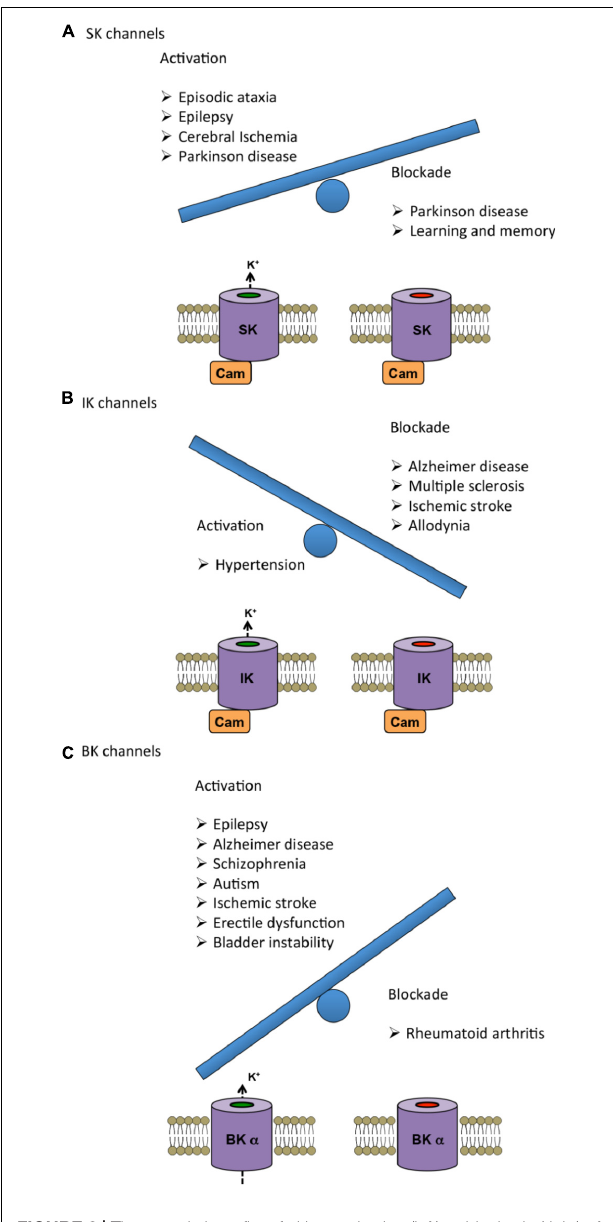
FIGURE 2 | Therapeutic benefits of either activation (left) or blockade (right) of K Ca channels represented as a weighing scale. The heavier balance indicates the modulation (activation or blockade) that has been reported advantageous in a larger number of diseases. (A,C) In the case of SK and BK channels, activation shows more beneficial effects than inhibition. (B) For IK channels, pharmacological blockade has proven to be more advantageous than activation. For further information about the specific effects, see Tables and main